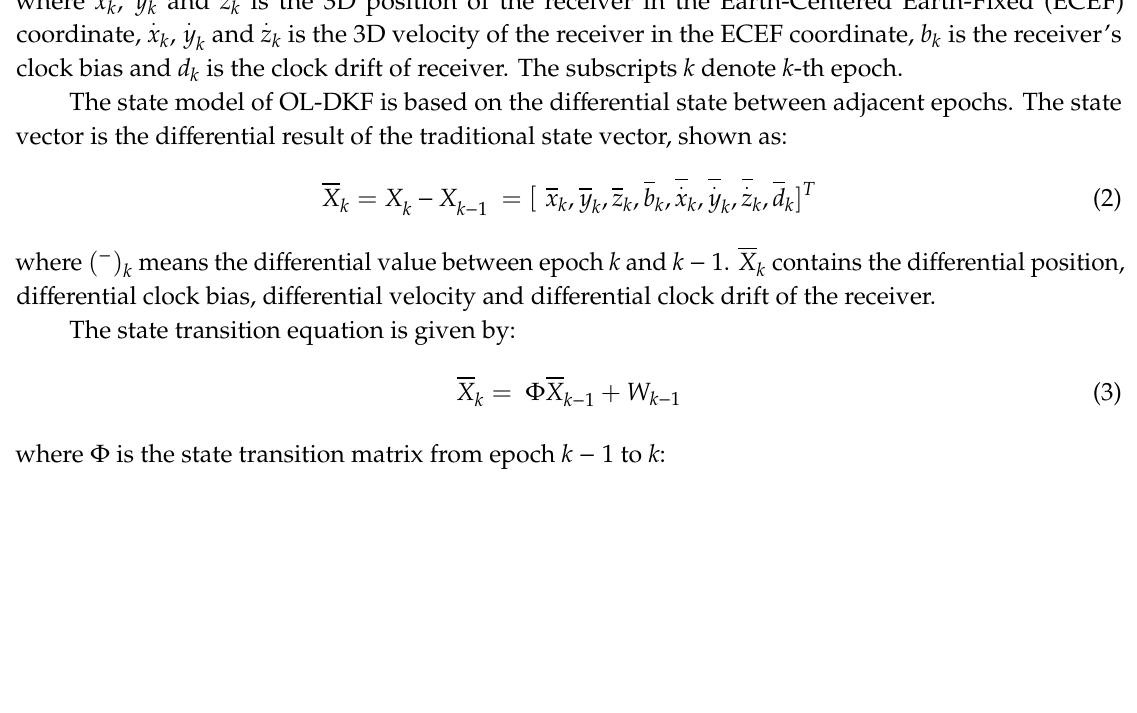
Figure 3. Diagram of open loop tracking with a differential Kalman filter.